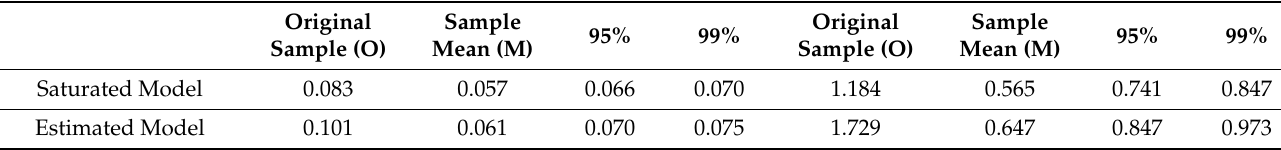
Table 9. Model fit analysis of the proposed model.